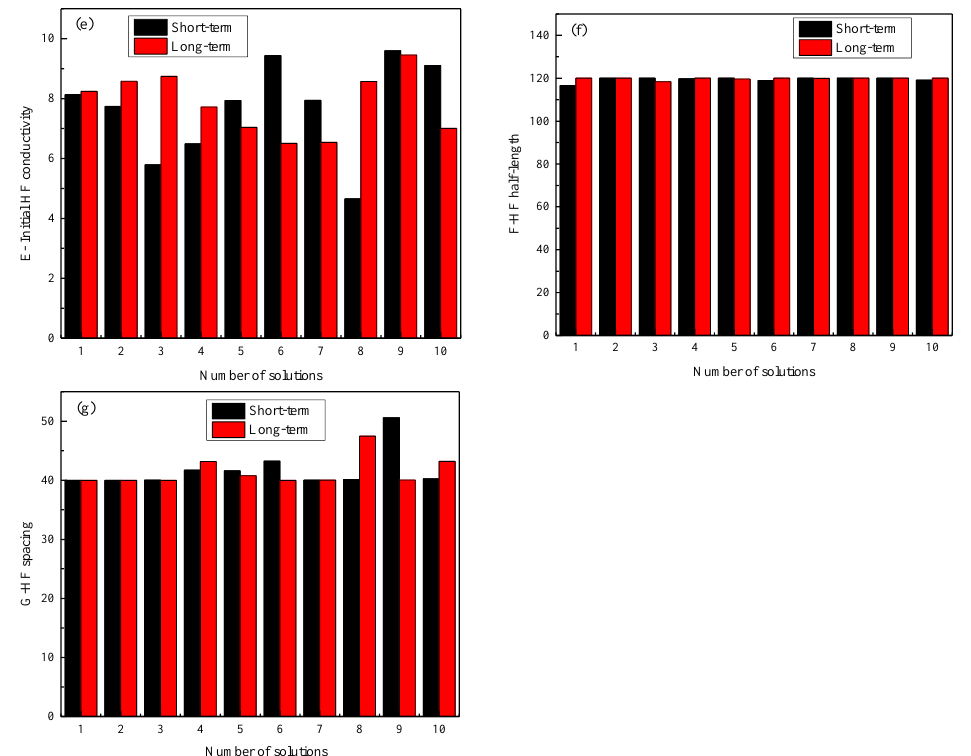
Figure 14. Magnitudes of variables for the desired top 10 solutions of GRR (( a ) Influence of matrix parameter; ( b – d ) are influence of natural fracture parameters; ( e – g ) are influence of hydraulic fracture parameters).